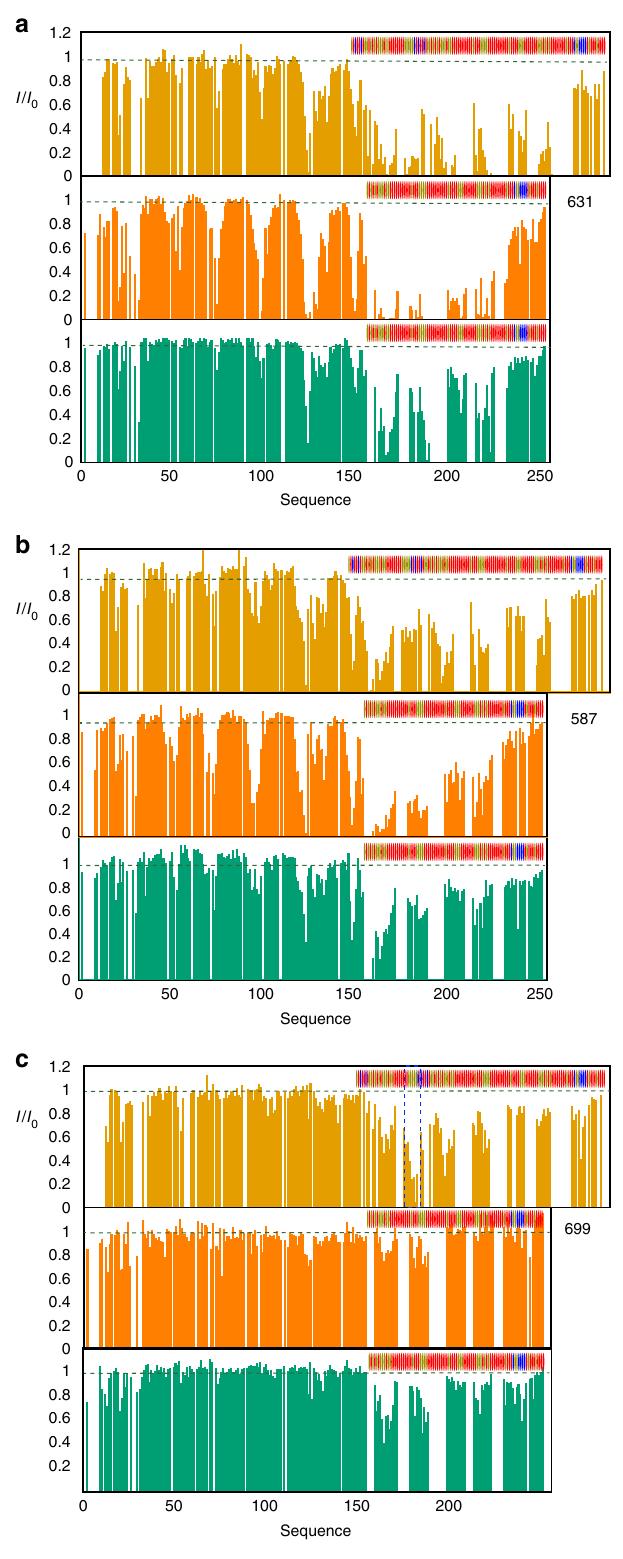
are found to be the same as for 627-NLS from IAV (Fig. 6b). In the case of full-length h ANP32A (Fig. 6c), the fi rst 50 amino acids of the IDD disappear from the spectrum, likely because the large particle results in extreme line broadening for the residues that are closest to the LRR domain due to slow tumbling in solution. Given the spectroscopic similarities of the interaction of ANP32A